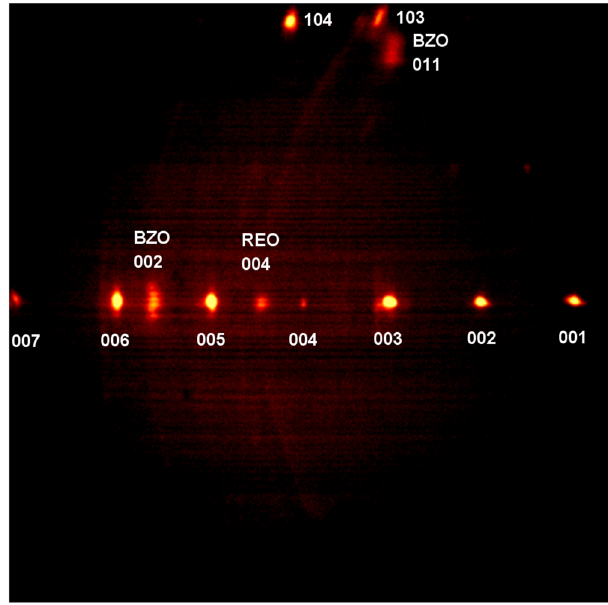
Figure 5. 2D-XRD diffraction pattern of 4.8 µ m thick REBCO tape with 15 mol% Zr addition processed by A-MOCVD in a single pass. BZO (011) peak is streaking in the direction perpendicular to nanorod length indicating a small nanorod